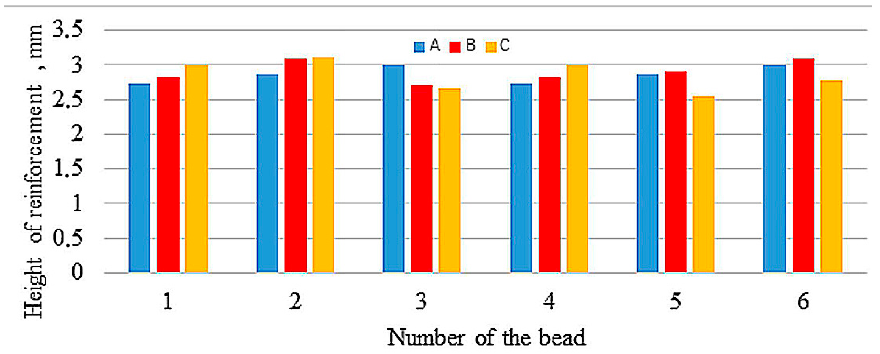
Figure 3. Reinforcement height of particular beads. Materials 2020 , 13 , x FOR PEER REVIEW